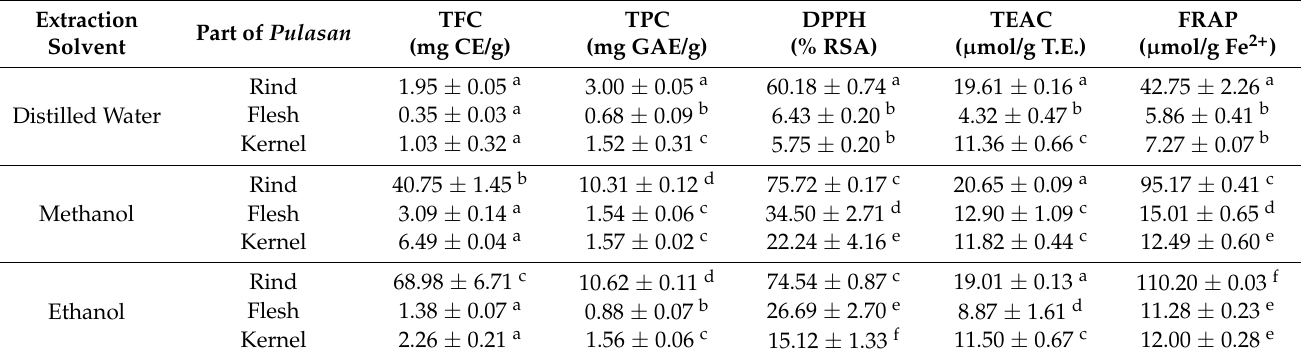
Table 1. The antioxidant properties of rind, fruit, and kernel of pulasan in different extraction solvents.